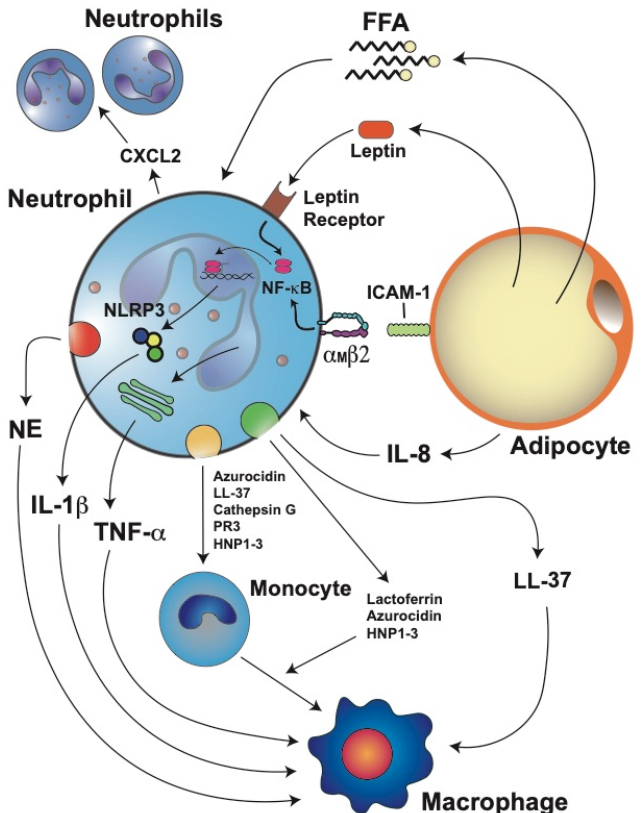
Figure 3. Stressed adipocytes in obese adipose tissue recruit neutrophils, which then further promote inflammation. Adipocytes produce adipokines such as leptin and cytokines such as interleukin-8 (IL-8). IL-8 is a potent chemoattractant for neutrophils. Once in the adipose tissue, neutrophils can recruit more blood neutrophils by releasing C–X–C motif chemokine ligand 2 (CXCL2), another important neutrophil chemoattractant. Neutrophils directly interact with adipocytes via the binding of integrin α M β 2 on the neutrophil to intercellular adhesion molecule 1 (ICAM-1) on the adipocyte.